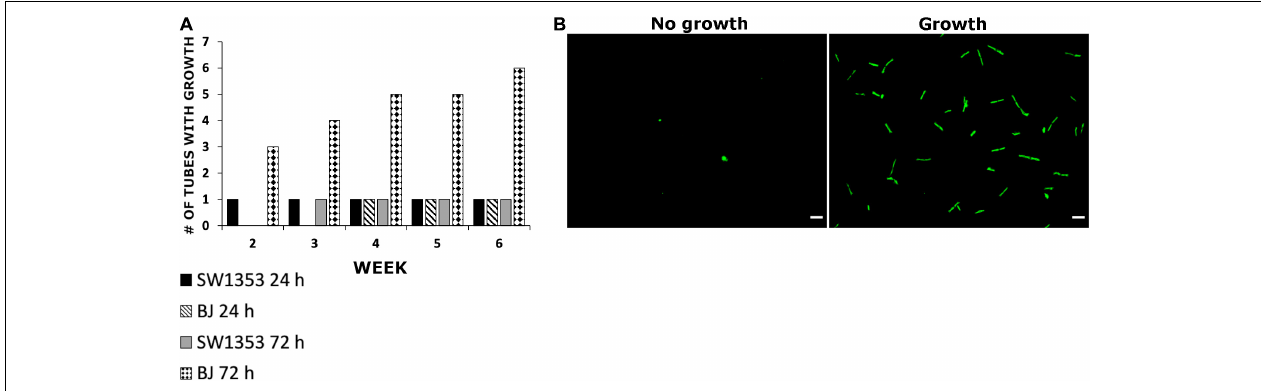
FIGURE 4 | Borrelia burgdorferi was able to regrow after being internalized into human cells. (A) SW1353 and BJ cells were infected with B. burgdorferi for 24 and 72 h, respectively. After each time point, the cells were thoroughly washed with PBS and treated with an acid wash (0.2 M glycine, 0.15 M NaCl, pH 3) for 30 s in order to get rid of any external bacteria. The cells were then placed into BSK II media for 6 weeks and observed weekly for borrelial growth using fluorescence microscopy. Growth was considered when samples contained multiple healthy looking and motile spirochetes (B) . The experiments were performed in triplicates and repeated three times, thus, totaling nine tubes for each cell line and time point. Scale bars 30 µ